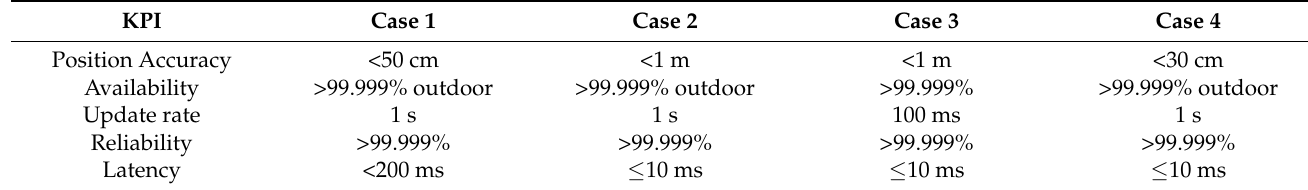
Table 3. Key KPIs of Testing and Typical Application Cases.